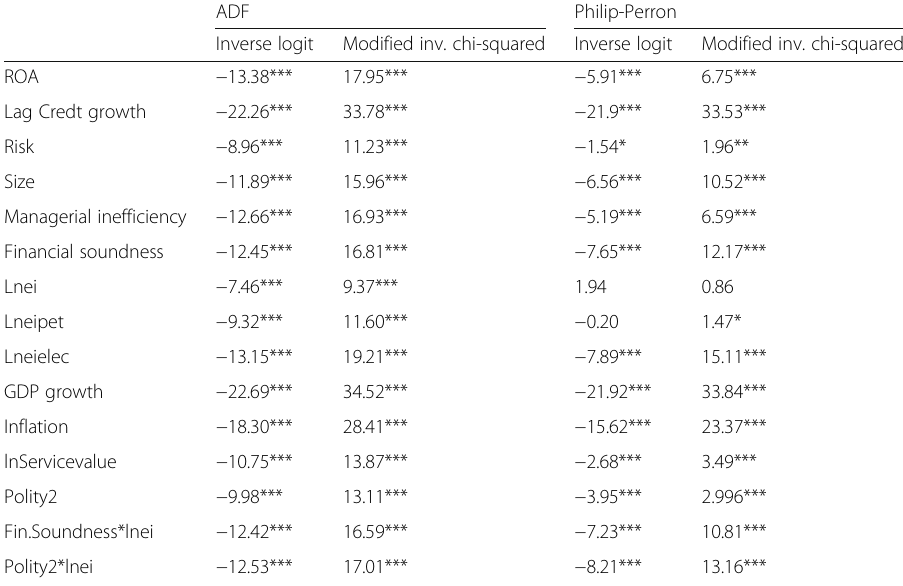
Table 3 Unit root